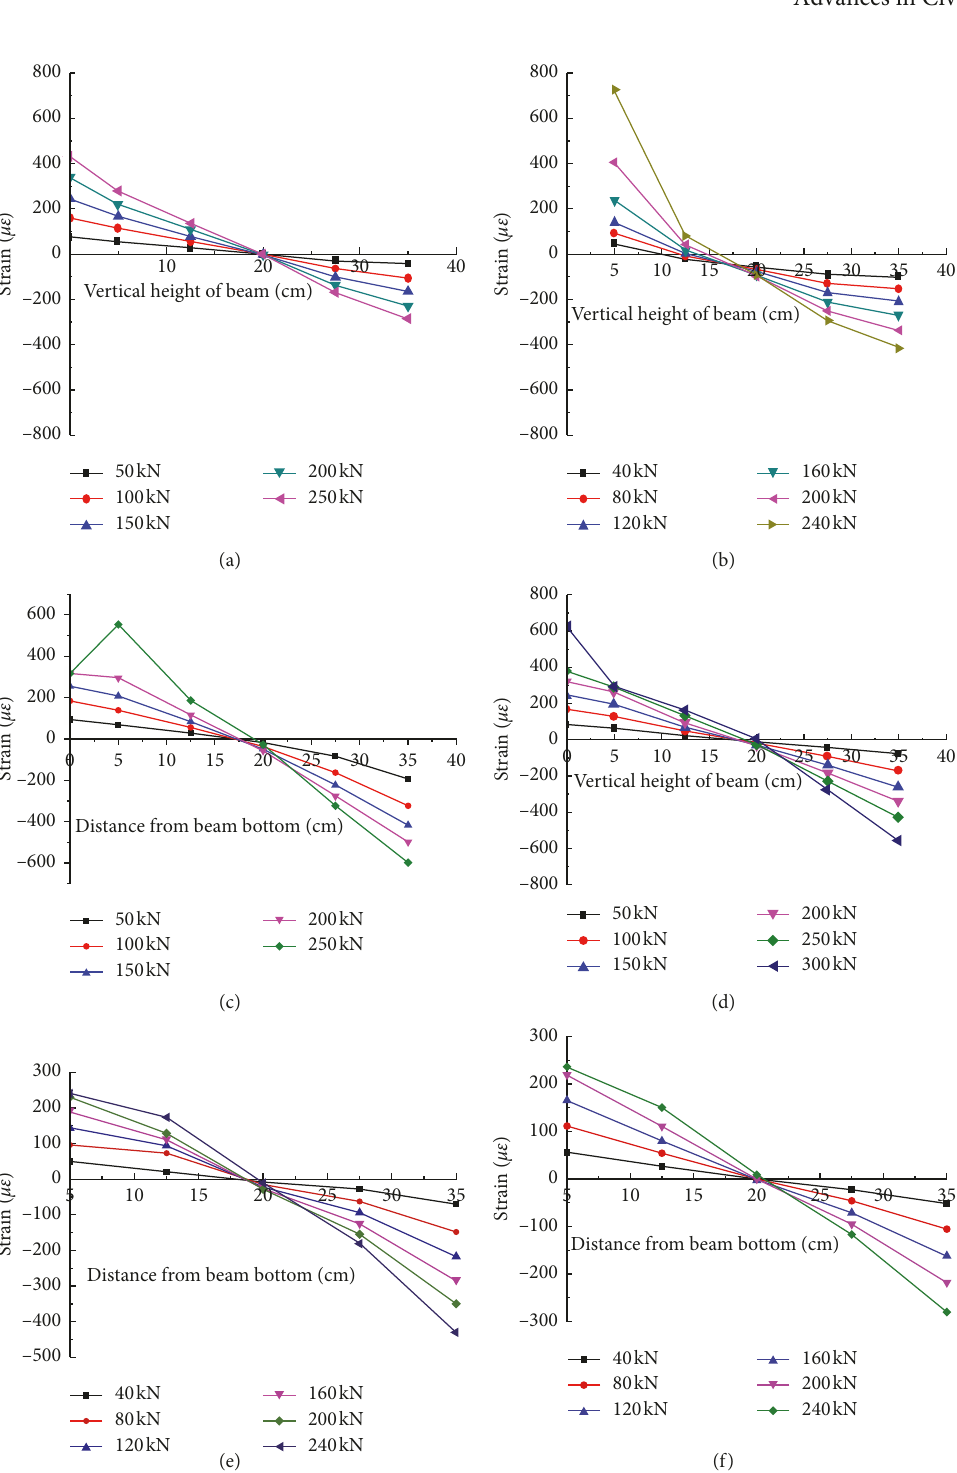
distribution through the concrete was similar, and the further from the neutral axis of the concrete girder, the larger the measured strain. With increasing load, the measured strains increased.